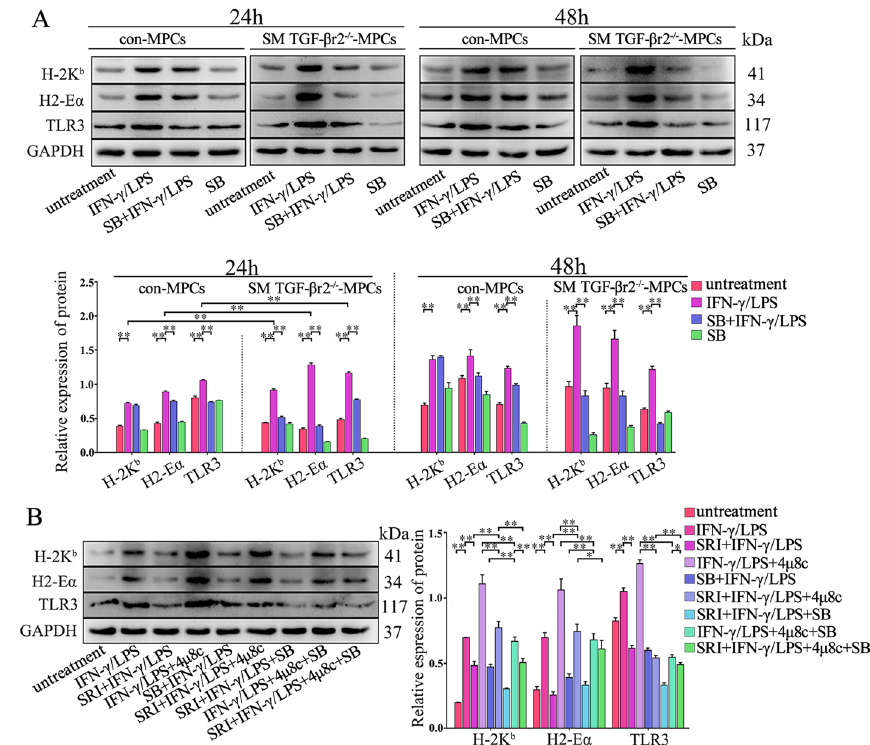
Fig. 10 TGF-β-IRE1α signaling inhibits immunological characteristics of muscle cells by attenuating p38 MAPK pathway. Western blot analyses of the expression changes of H-2K b , H2-Eα, or TLR3 in MPC-myotubes derived from Con and SM TGF-βr2 − / − mice ( A ), or in TGF-βr2 − / − MPC-myotubes ( B ) with or without stimulation of IFN-γ/LPS, SRI, 4μ8C, and/or SB (p38 pathway inhibitor). The relative protein expression values are expressed as a ratio (protein of interest/GAPDH). All data are presented as means ANOVA was used for multiple comparisons (* P < 0.05; ** P <